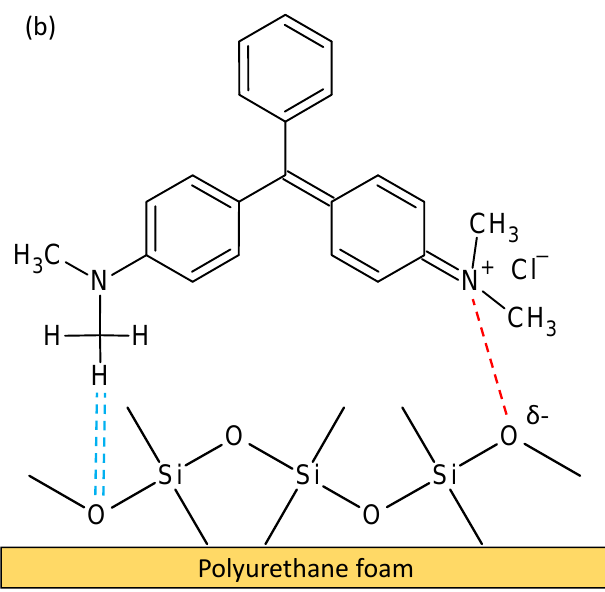
Figure 11. The proposed adsorption mechanism of ( a ) MB and ( b ) MG onto FMS/PU.